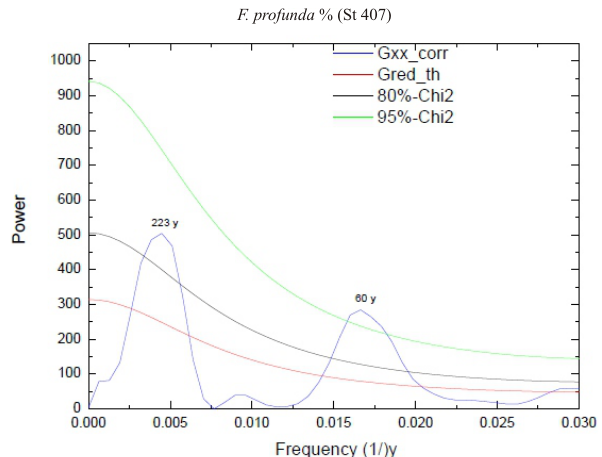
Fig. 8. Bias-corrected power spectrum (REDFIT) of the unevenly sampled F. profunda abundance signal at St 407. The green line and the black line respectively indicate the 95% and the 80% confi- dence level. The red line indicates the AR(1) theoretical red-noise